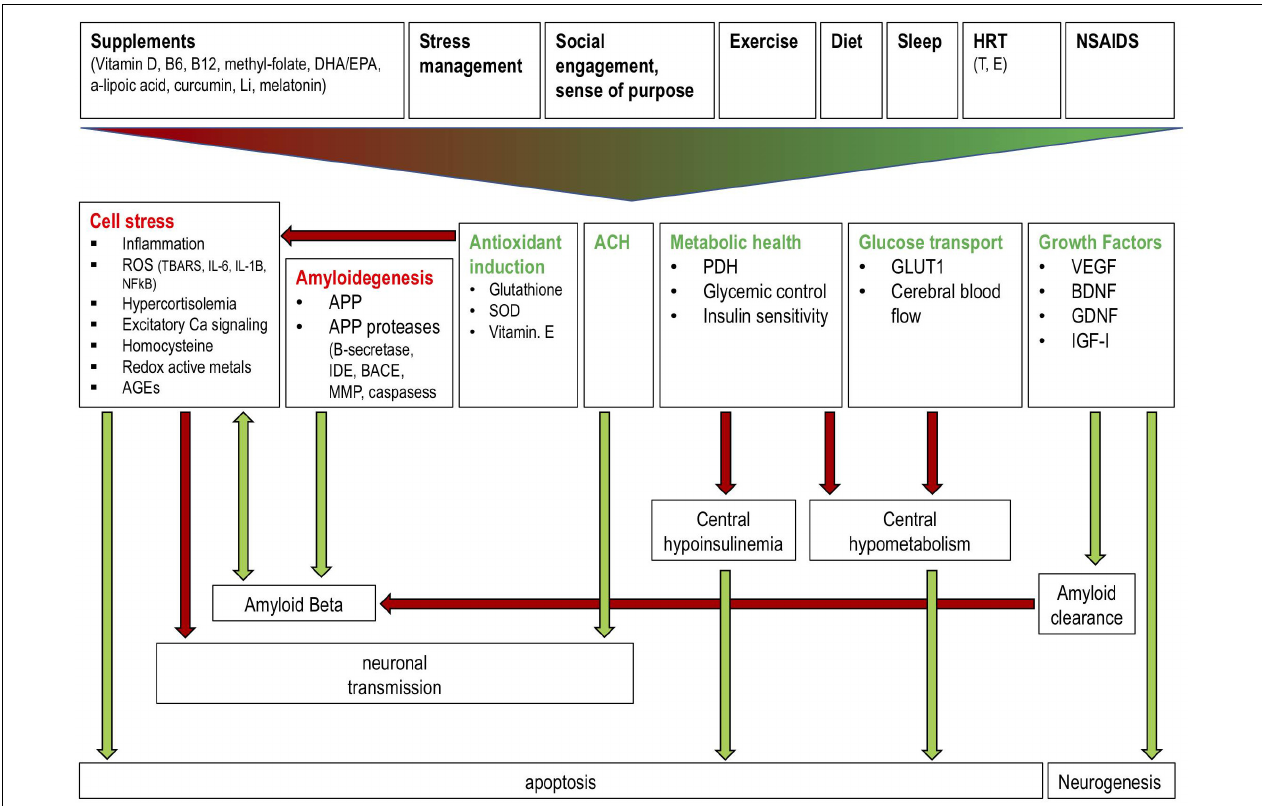
FIGURE 2 | Effects of a polytherapeutic approach on AD mechanisms. Interventions (supplements, stress management, social engagement and sense of purpose, exercise, diet, sleep, HRT, NSAIDs) collectively reduce (red text) and stimulate (green text) factors which influence amyloid beta generation and clearance, central insulin and glucose metabolism, neuronal transmission, and neurogenesis. Green and red arrows indicate one factor increasing or decreasing another, respectively. Antioxidant induction reduces cell stress thereby preventing reduced neuronal transmission and enhanced AB generation and apoptosis. Amyloidogenic factors increase AB production while growth factor (e.g., IGF) mediated amyloid clearance reduces AB. ACH improves neuronal transmission. Metabolic health and glucose transport factors prevent a central hypoinsulinemic and hypometabolic state which prevents apoptosis. Growth factors stimulate neurogenesis. Li: